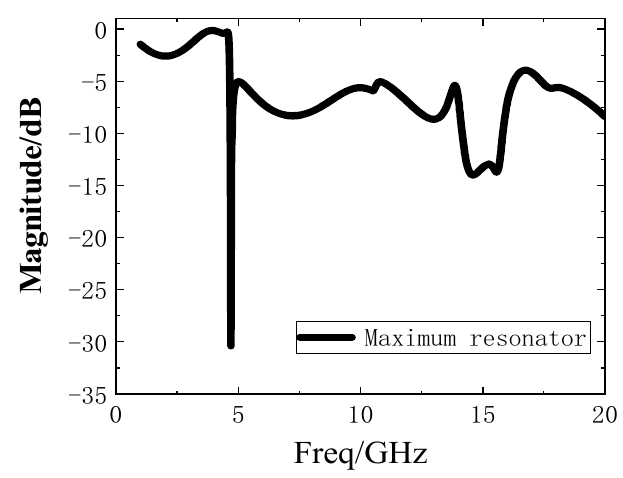
Figure 18. The maximum resonators of the 31-bit retransmitted chipless tag.